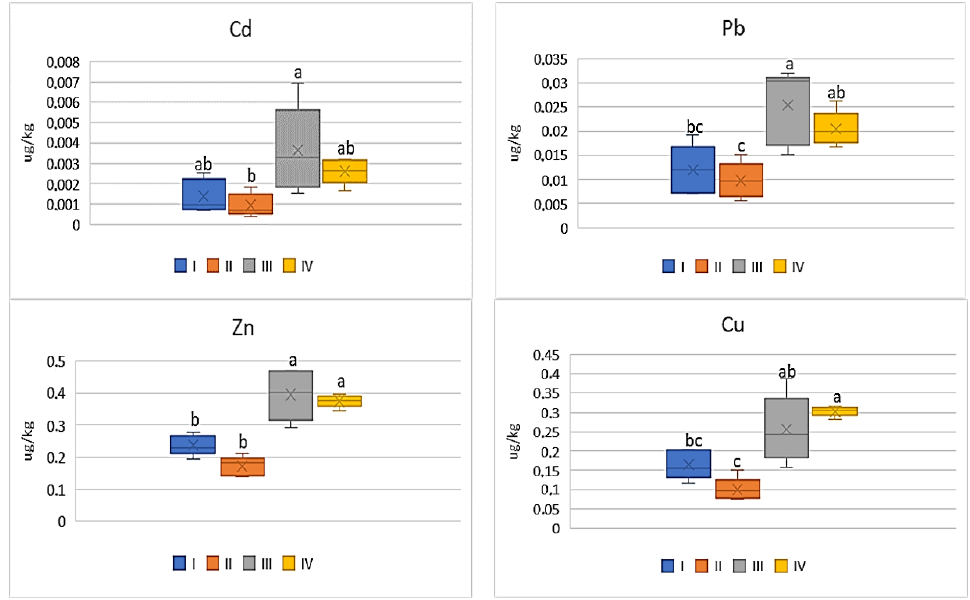
Figure 12. DIM values for beetroot depending on the metal and study zones. The same letters mean no significant differences between the values.